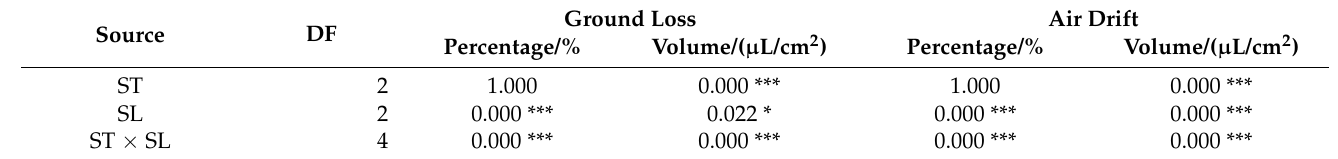
Table 6. ANOVA results ( p -values) for variables and interactions to assess pesticide loss.